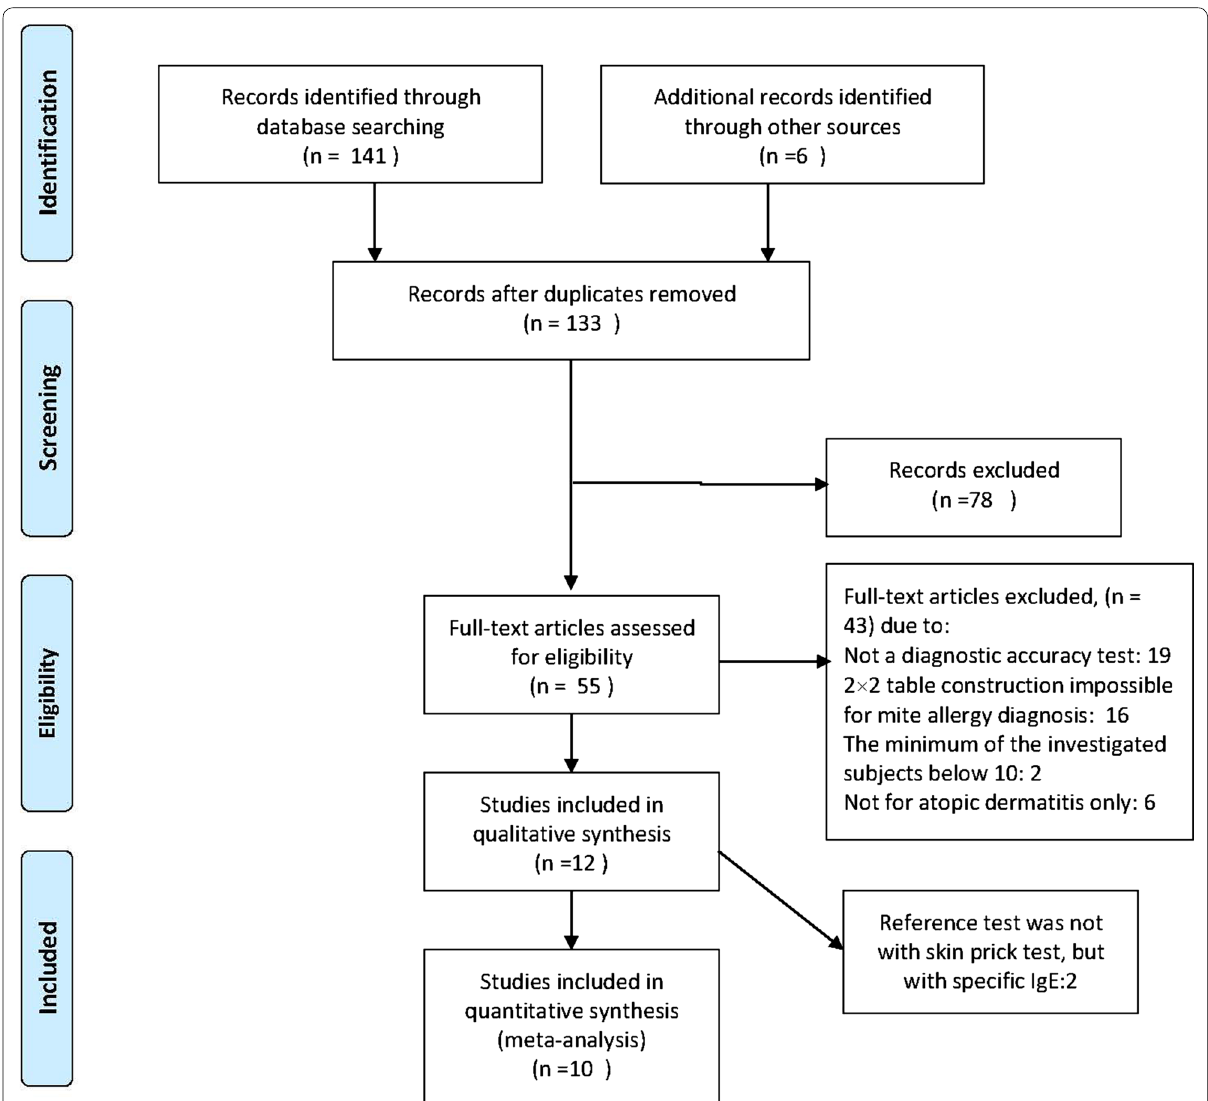
Fig. 1 Flow chart depicting the search and selection strategy for eligible studies. n number of